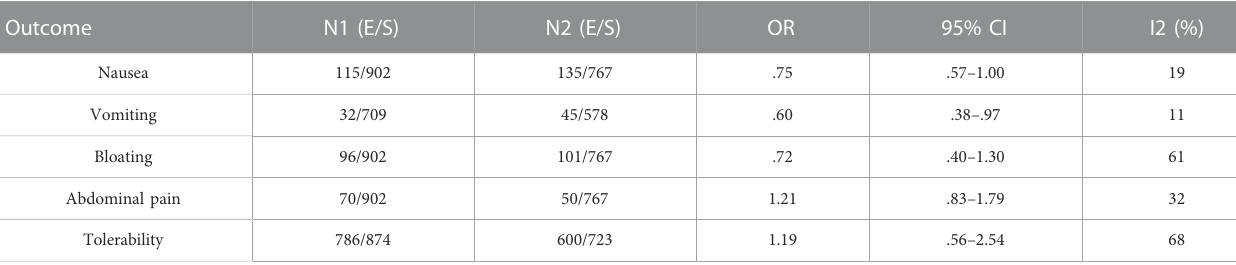
TABLE 4 Secondary outcomes of intensive regimen vs. standard